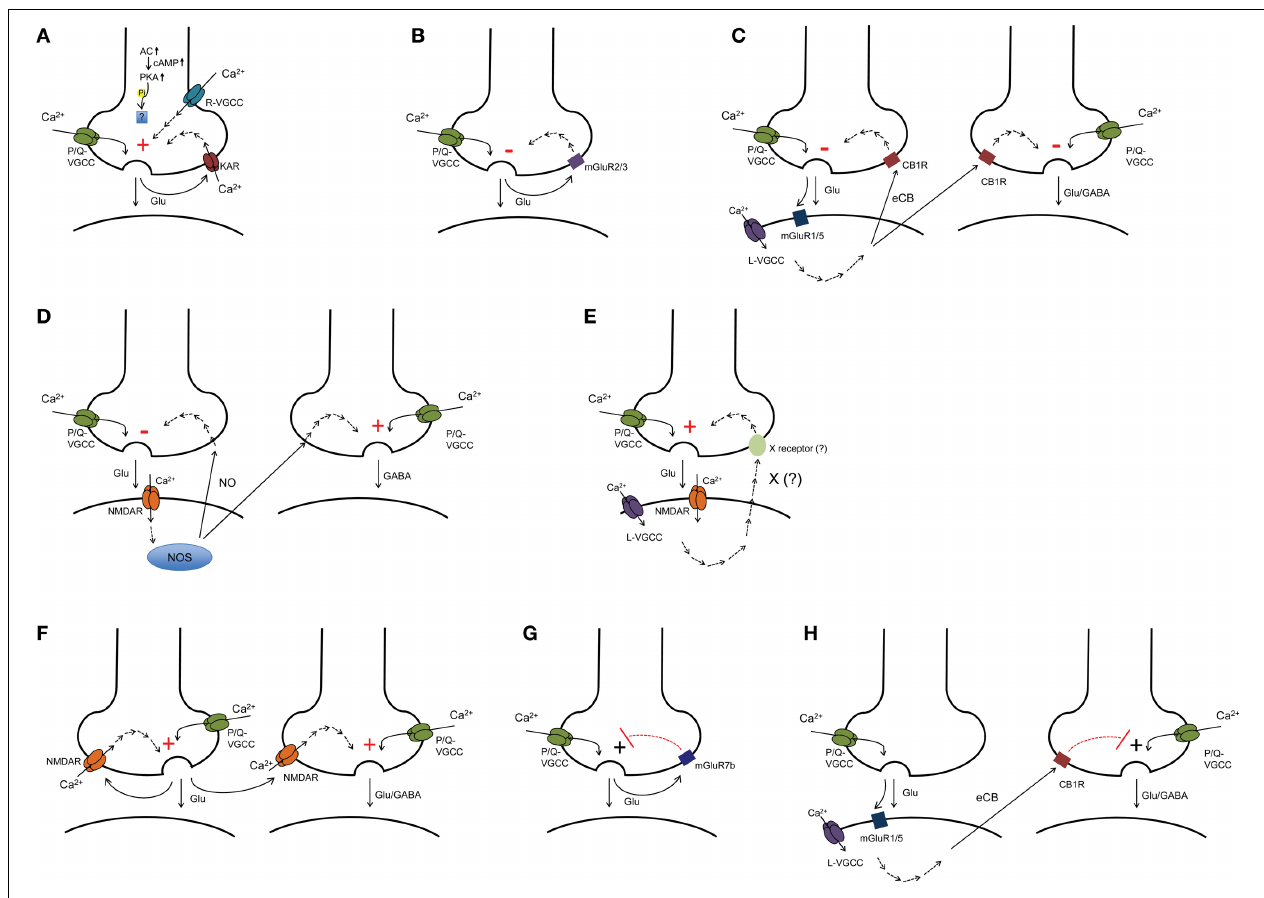
FIGURE 1 | Induction mechanisms identified for presynaptic LTP and LTD. (A,B) presynaptic plasticity induced presynaptically (e.g., mossy fiber LTP and LTD). (C) eCB-dependent homosynaptic and heterosynaptic LTD. (D) NO-dependent LTD at excitatory synapses and LTP at inhibitory synapses. (E) postsynaptically induced LTP with as yet unidentified retrograde signaling mechanism (e.g., CA3-CA1 LTP). (F) presynaptic NMDAR-dependent homosynaptic and heterosynaptic LTP (e.g., LTP at cortico-LA synapses). (G) presynaptic